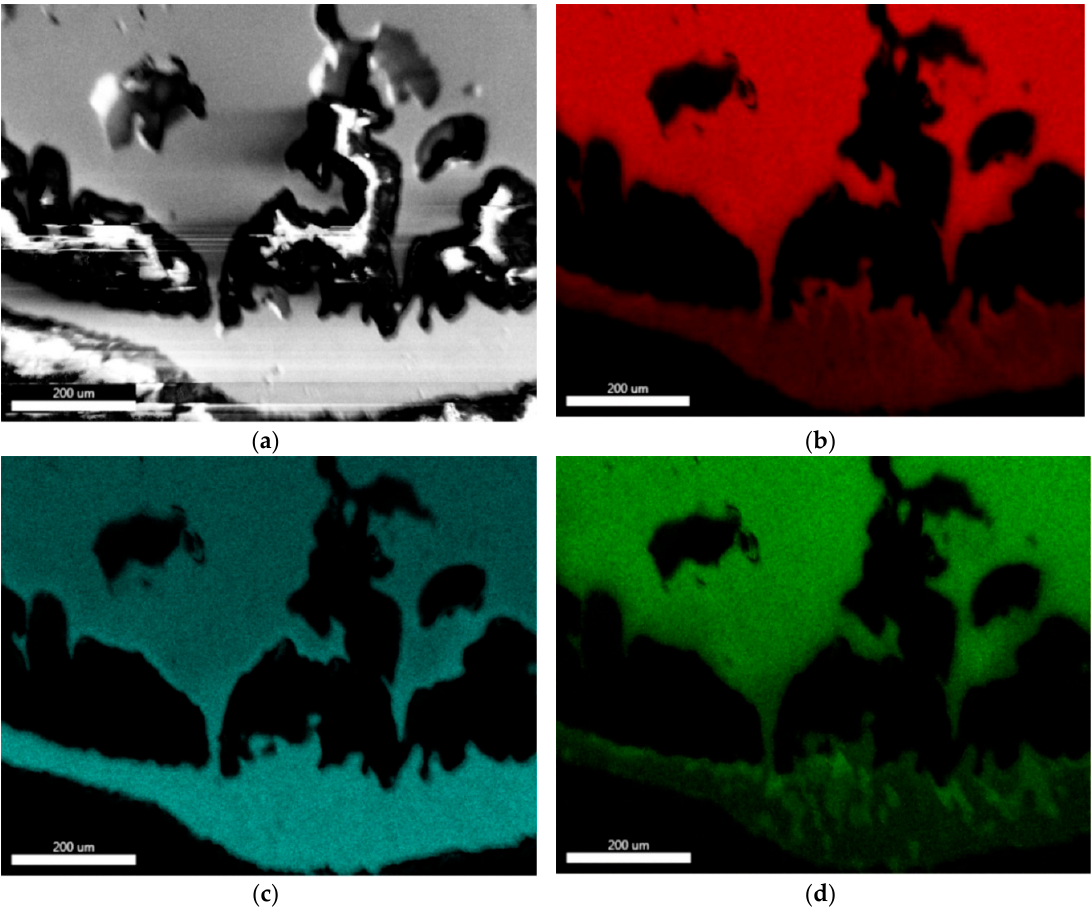
Figure 7. ( a ) The micrograph of the surface of the 1000 ppm B sample, showing pore formation due to sublimation (here, the bottom part depicts the outer layer) and used for elemental distribution mapping, ( b ) Co elemental distribution map, ( c ) Re elemental distribution map and ( d ) Cr elemental distribution map.